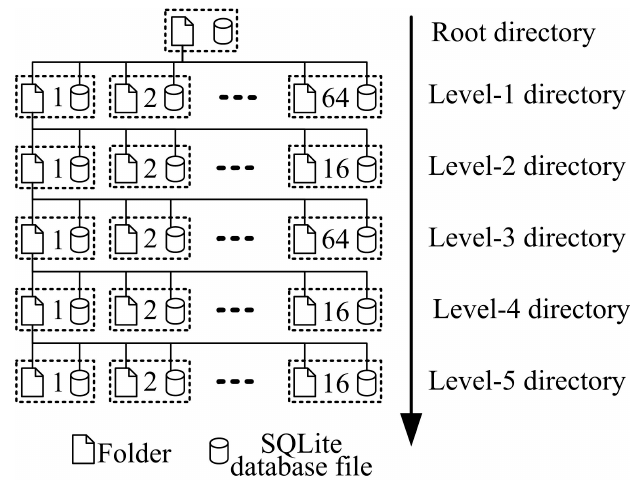
Figure 7. File catalog organization model of a PDF tile map. For Levels 2–5 only the directory structure for the first element is shown and the remaining ones have a similar structure.